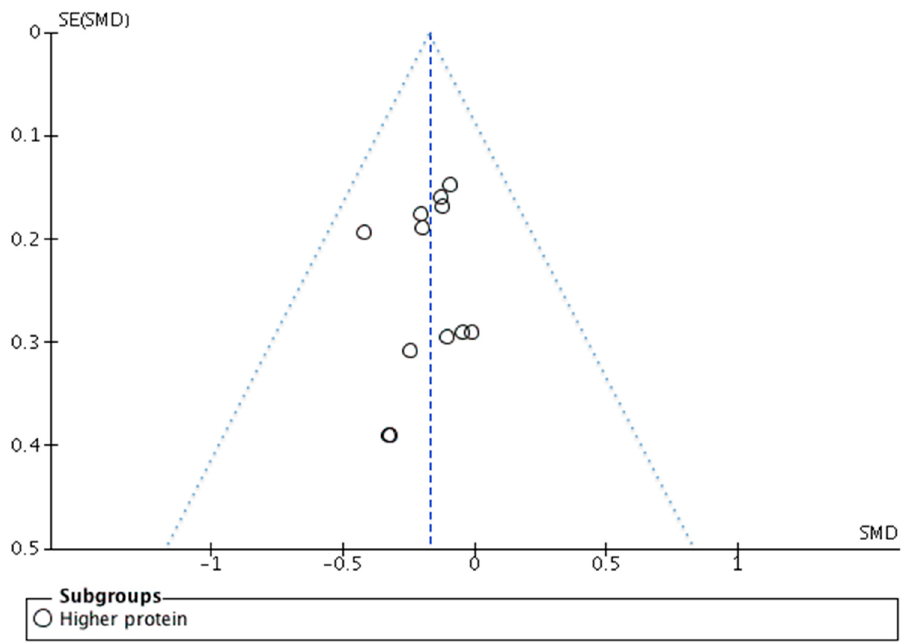
Figure 4. Funnel plot of the protein studies included in the meta-analysis. SMD, standardized mean difference, SE (SMD), standard error of SMD.